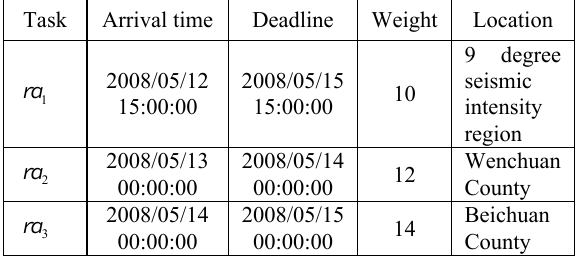
Table 1. The information about emergent tasks